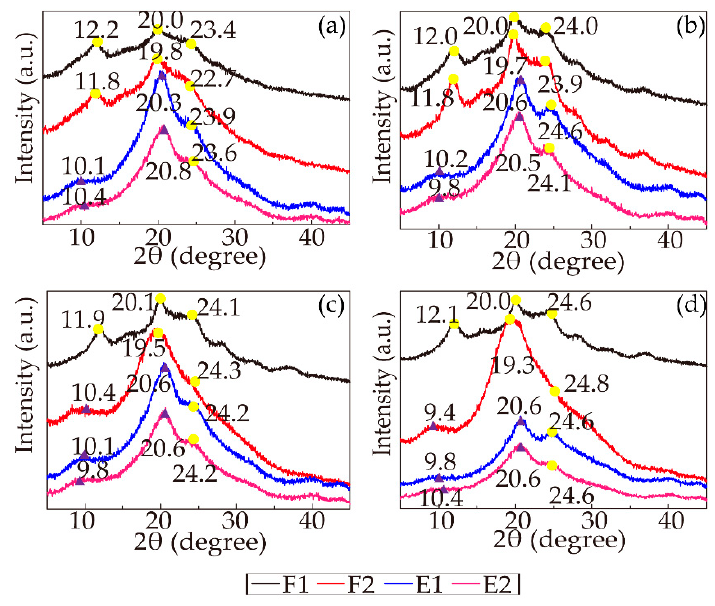
Figure 7. X-ray spectra of all the RSF samples (the yellow points represent Silk I, and the purple triangles represent Silk II): (a) 19%; (b) 22%; (c) 25%; (d) 28%.